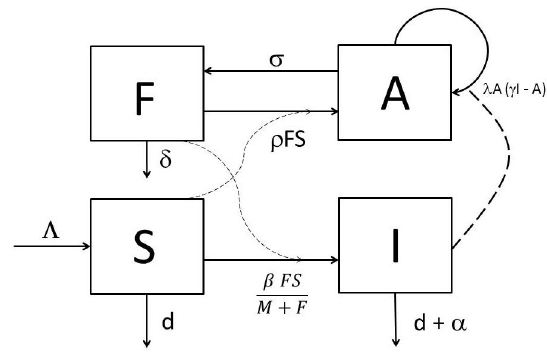
Fig. 1. Flow chart of the host-pathogen